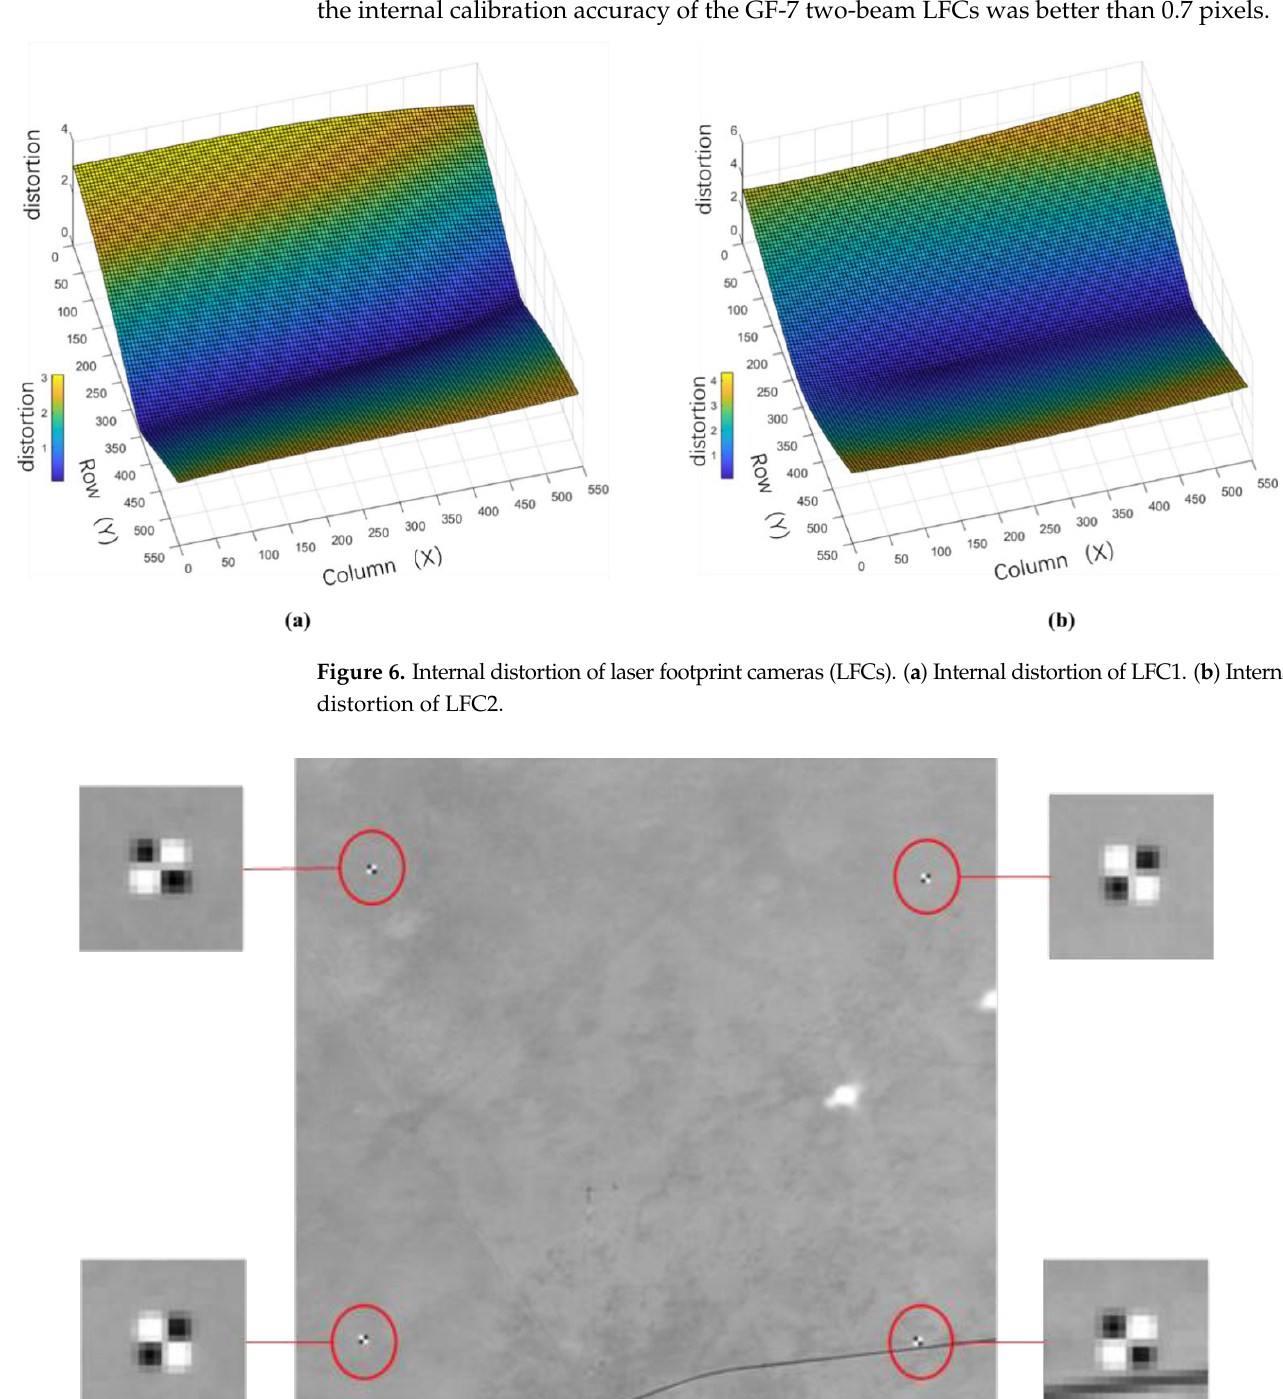
Figure 7. Ground targets on footprint images.